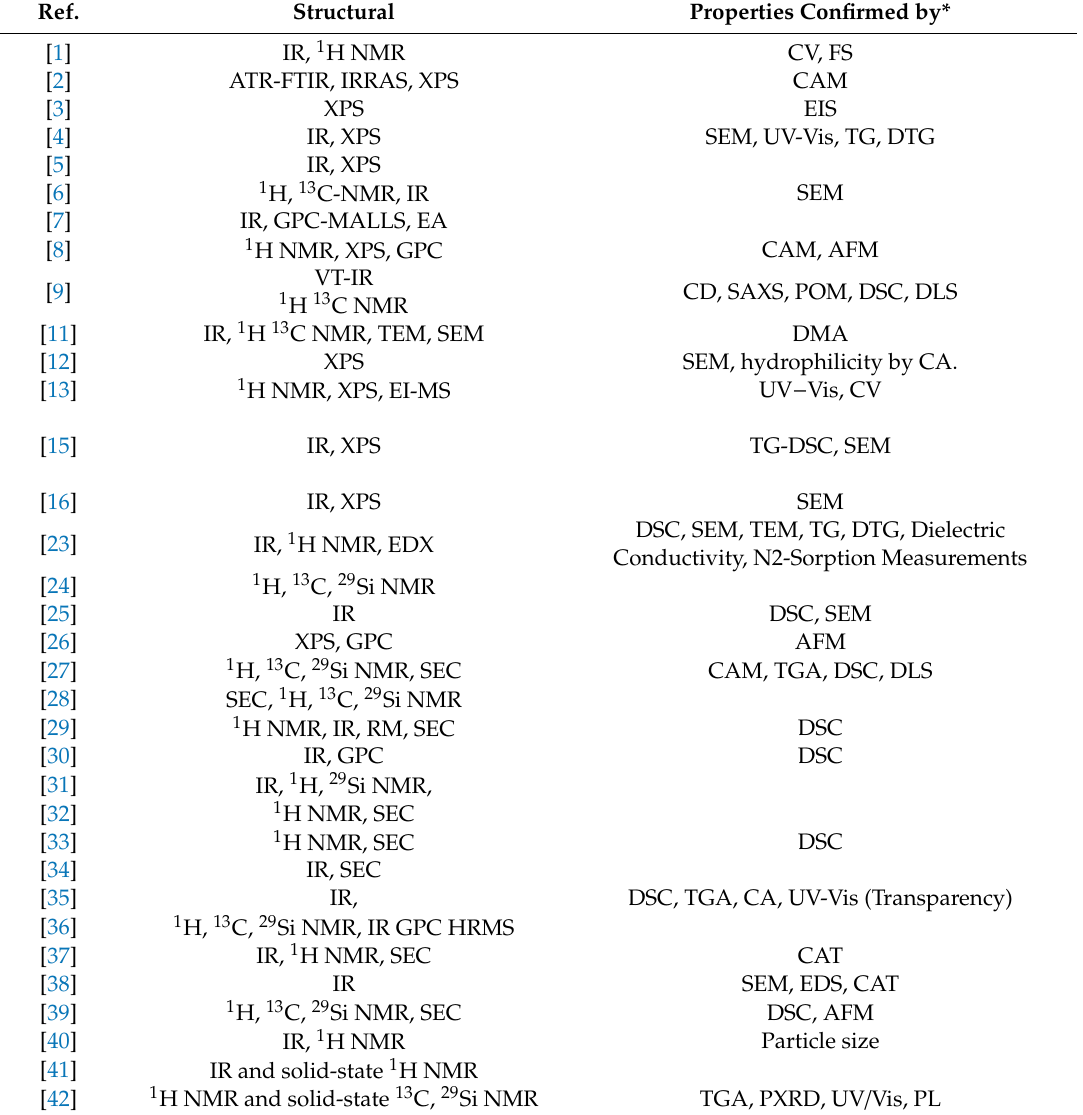
* Abbreviations are explained in the relevant abbreviations